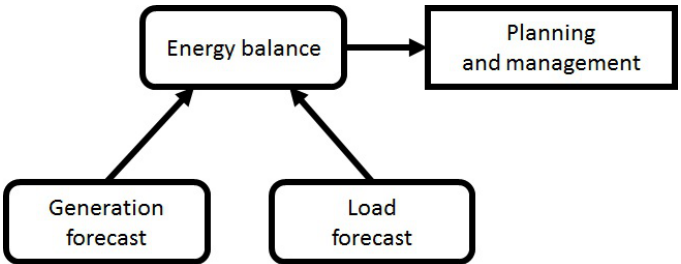
Figure 1. Balancing of the electric power system or local energy